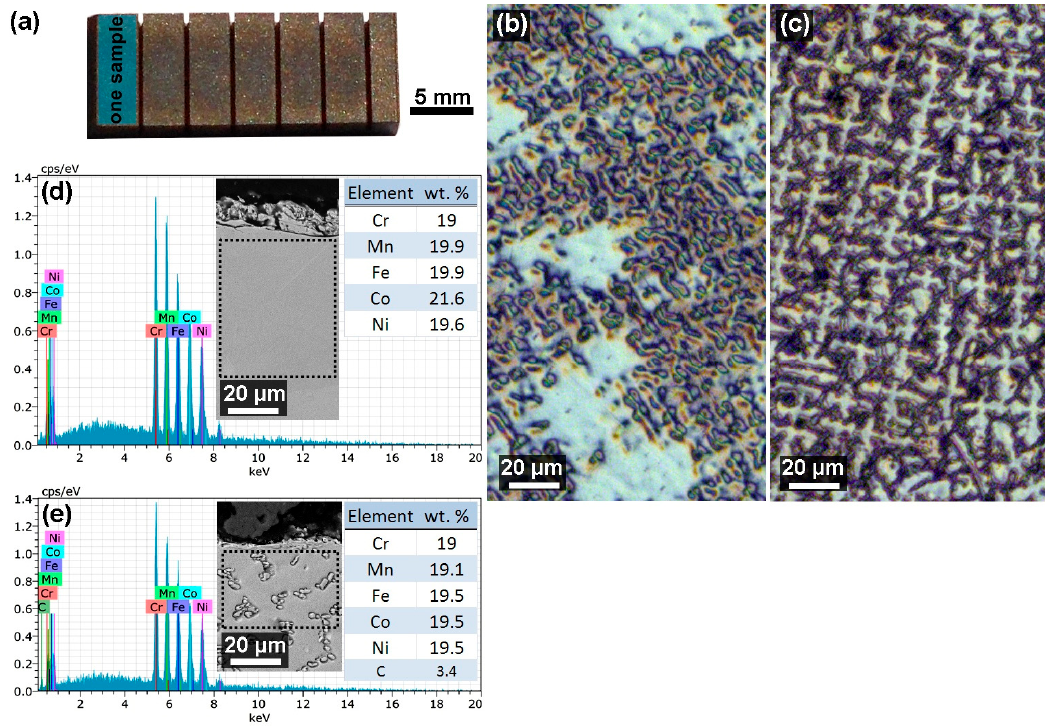
Figure 1. ( a ) An example of produced samples within the experiment with marking of the surface of one sample; ( b ) microstructure of 1Fe material; ( c ) microstructure of 1Fe0.2C material; ( d ) the analysis of the chemical composition of 1Fe material at a given place according to the scanning electron microscope (SEM) image; ( e ) the analysis of the chemical composition of 1Fe0.2C material at a given location according to the SEM image.